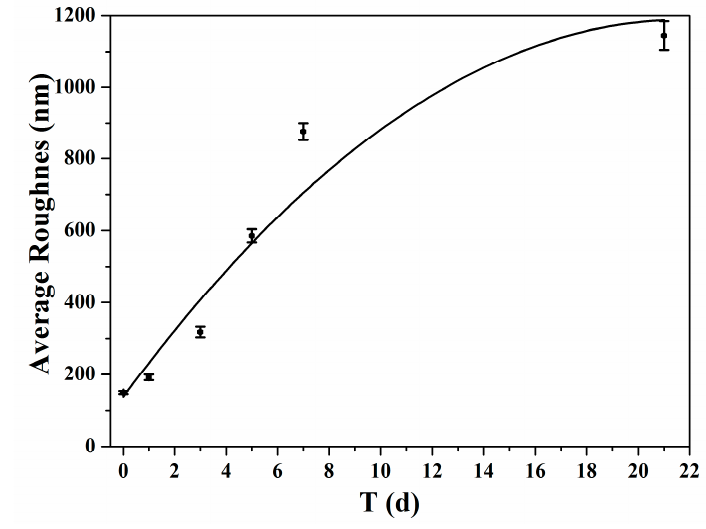
Figure 7. Average Roughness figure of PLA nano fibers with different mineralization time.